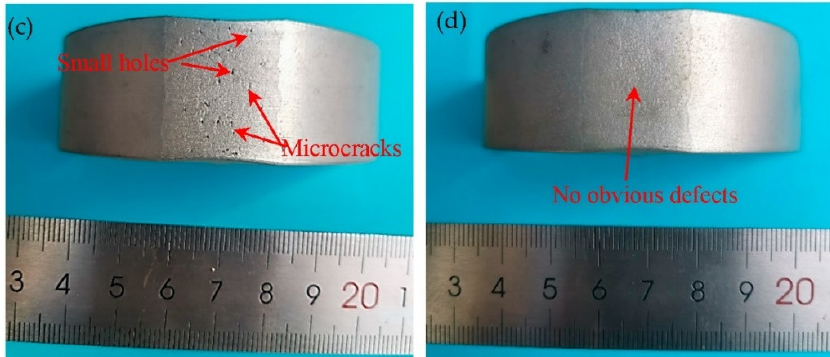
Figure 9. Macro characterization of the bend specimens, ( a , c ) ER5356 weld joint, ( b , d ) ER5087 welded joint .